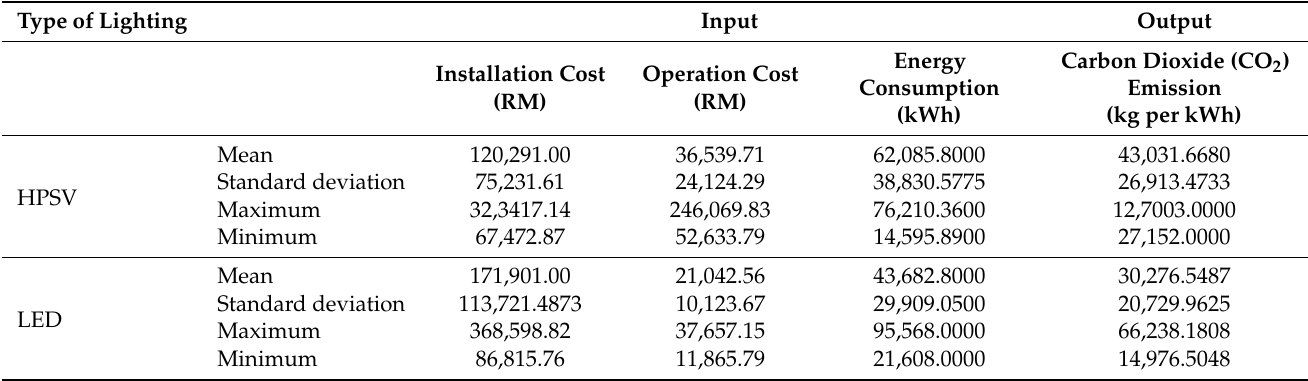
Table 3. Descriptive Statistics of Input and Outputs for HPSV and LED Road